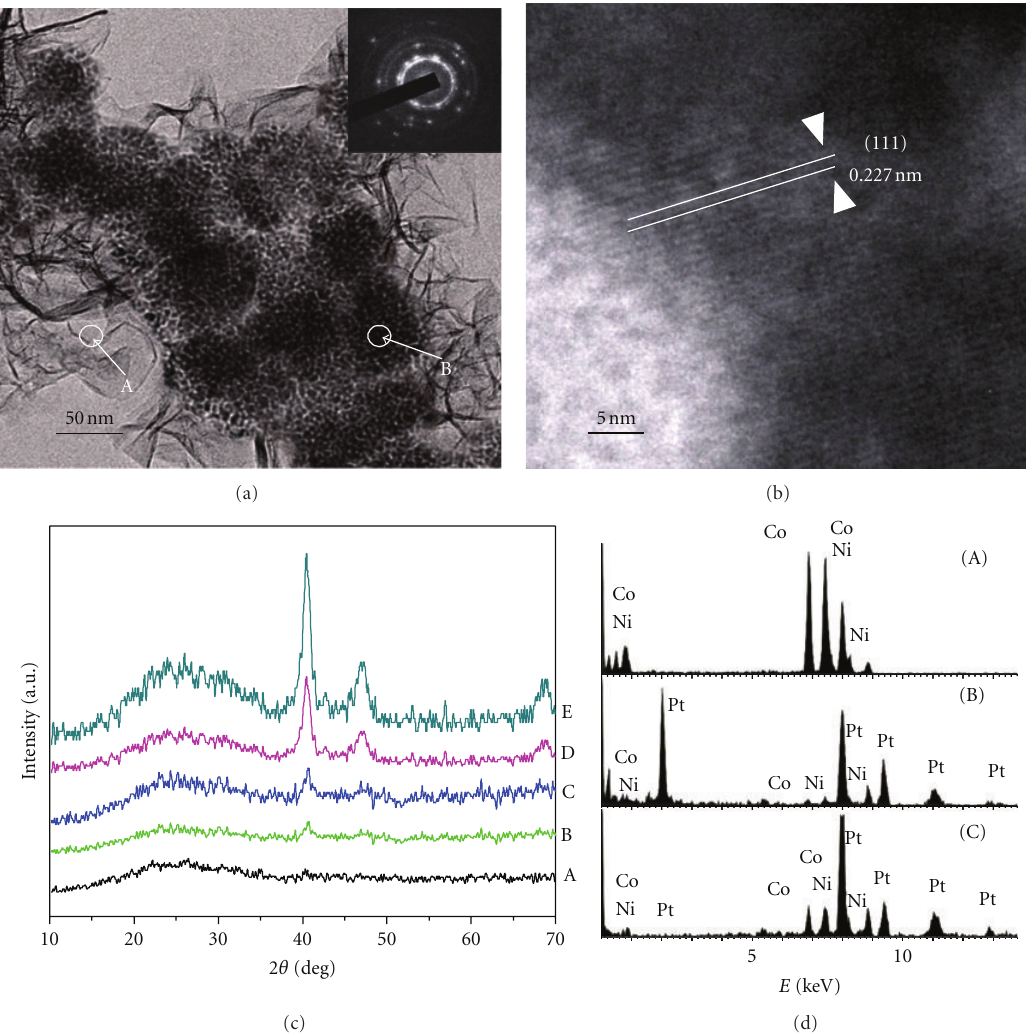
Figure 1: As-synthesized Pt-on-NiCo nanostructures: (a) TEM image; (b) HETEM image; (c) XRD patterns of (A) Ni 50 Co 50 , (B) Pt 5 -on- NiCo, (C) Pt 12 -on-NiCo, (D) Pt 53 -on-NiCo, and (E) Pt 71 -on-NiCo nanostructures; (d) In-situ EDX spectra in the area of (A) and (B), and area-scan EDX spectrum